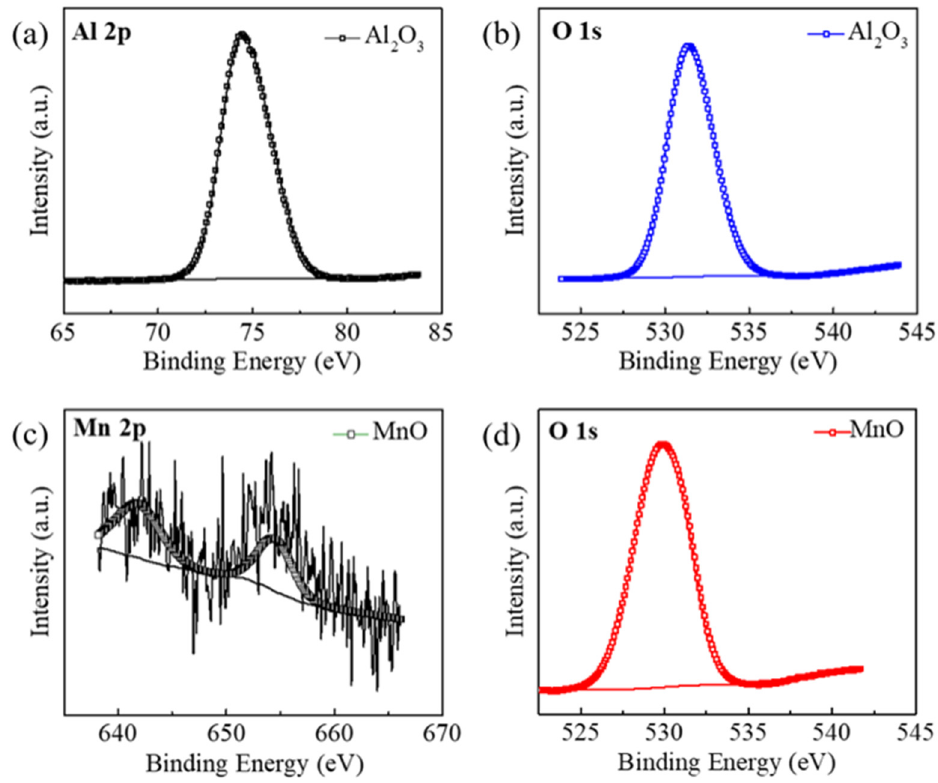
Figure 3. ( a , b ) XPS spectra of Al 2p and O1s for δ − Al 2 O 3 . ( c , d ) XPS spectra of Mn 2p and O 1s for MnO.